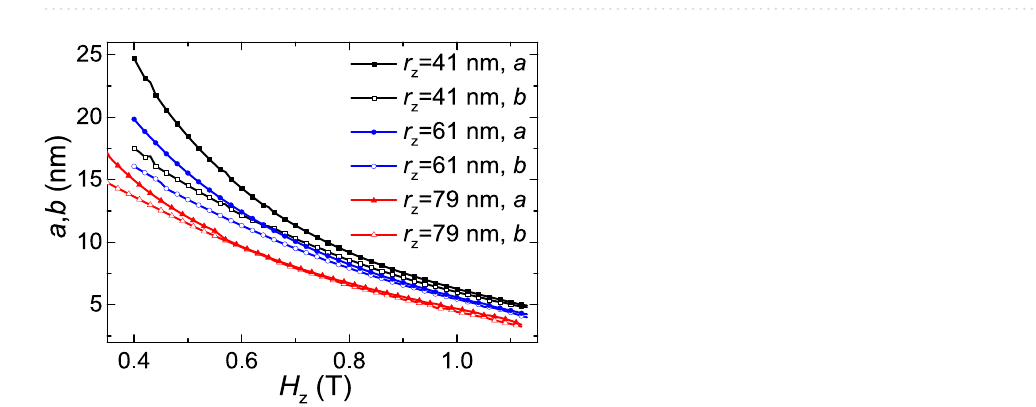
Figure 3. ( a ) Vector plot of the skymion state in a nanotube ( R = 80 nm and r = 40 nm) at H z = 0.37 T. ( b )–( d ) m z -image in x - s arc plane for different r z .